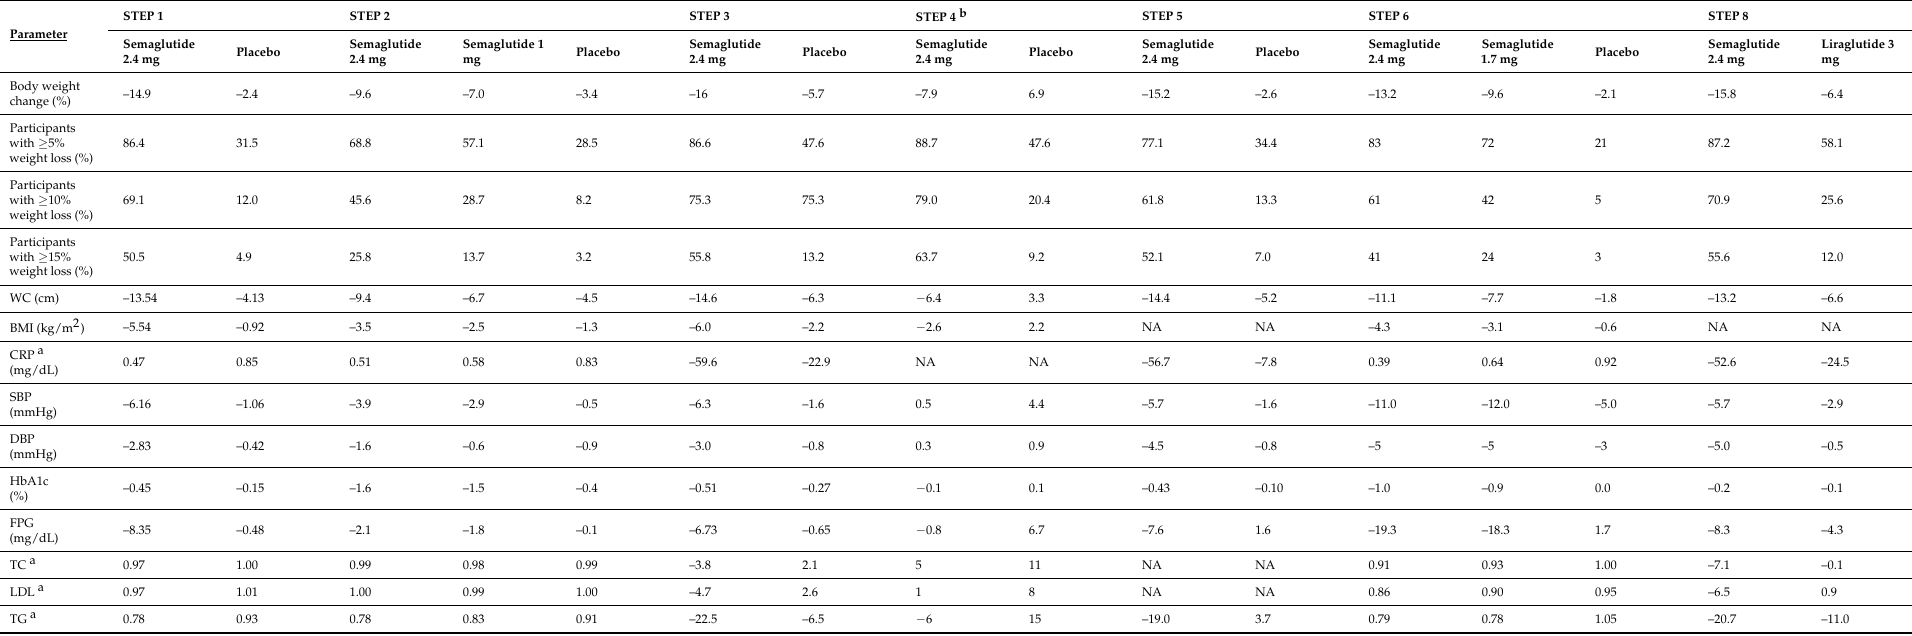
Table 2. Change in the main efficacy endpoints from baseline to end of treatment for STEP 1–6 and 8